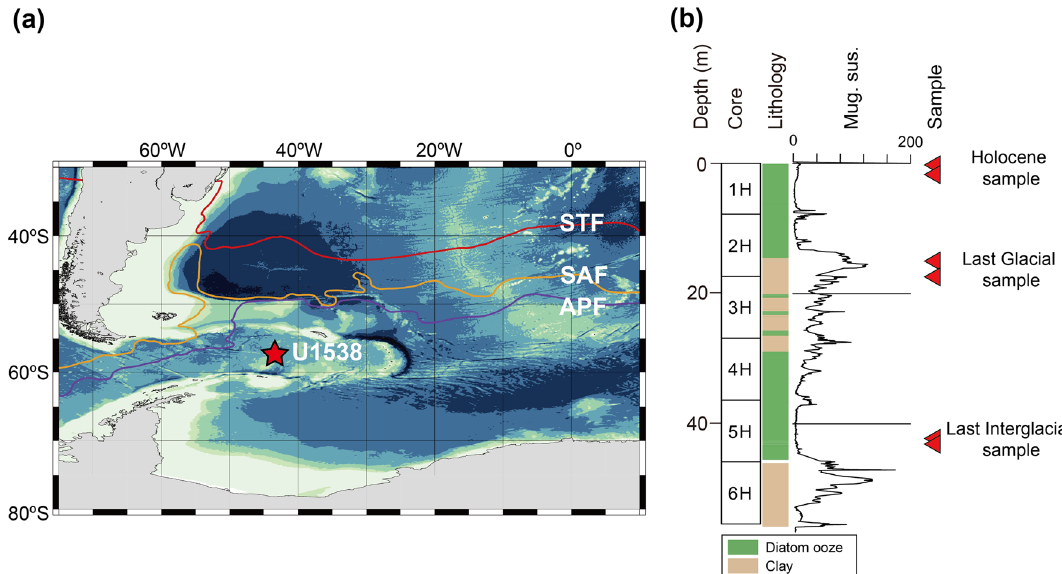
Fig. 1 Location and core profile of the studied samples. a Map showing the location of the drilling site (IODP Expedition 382 Site U1538). APF: Antarctic Polar Front, SAF: Subantarctic Front, STF: Subtropical Front. b Horizons of the six samples analyzed in this study (red triangles) together with lithology and magnetic susceptibility (Weber et al.